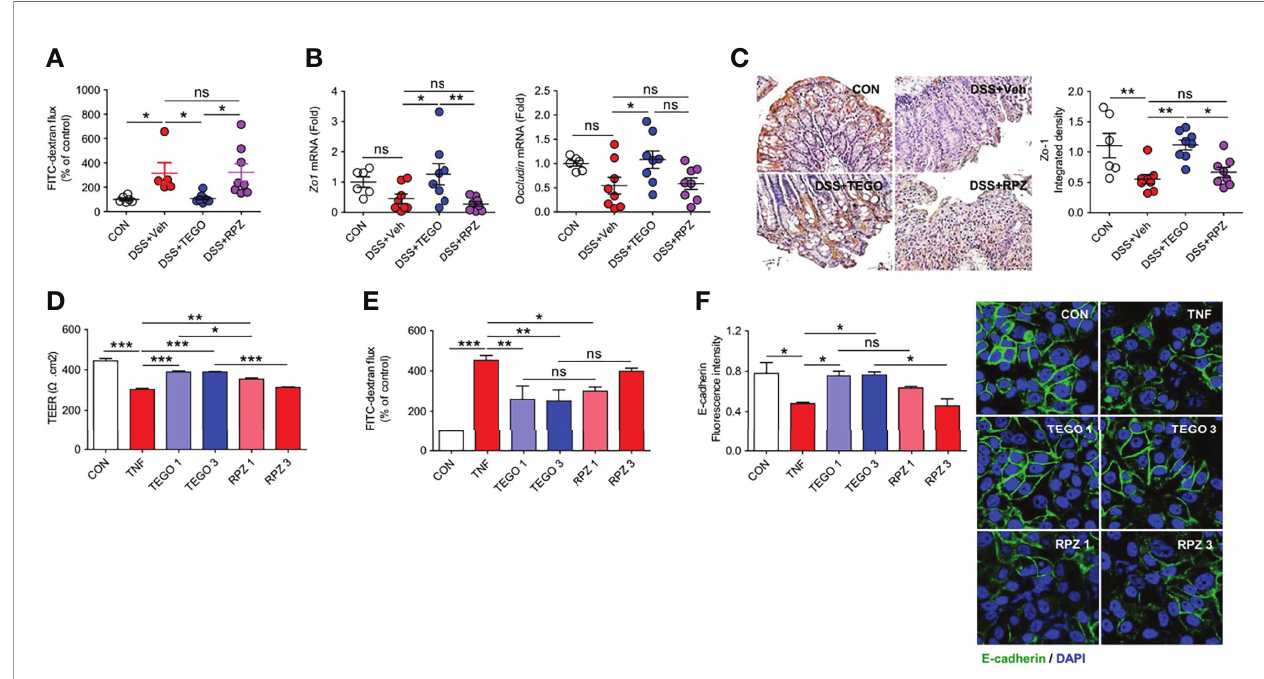
FIGURE 3 | Tegoprazan restores intestinal epithelial barrier function. (A – C) In vivo intestinal permeability assay using the DSS model was described in online methods: CON (n = 6), DSS+Veh, DSS+TEGO, and DSS+RPZ (each n = 8). (A) FITC-dextran fl ux (arbitrary unit), plotted as percentage of control. (B) Gene expression level of Zo1 and Occludin . Data represent the mean of triplicate real-time quantitative RT-PCR. (C) Representative immunohistochemical images and densitometric analysis of Zo-1 protein. (D – F) Caco-2 cell monolayers in a Transwell plate or culture plate were treated with TNF- a (40 ng/mL) for 48 h to disrupt the epithelial barrier. (D) TEER measurement. (E) FITC-dextran fl ux (arbitrary unit), plotted as a percentage of control. (F) Quanti fi cation of the fl uorescence intensity of E- cadherin (arbitrary unit) and representative image of E-cadherin. Data represent the mean ± standard error of the mean (S.E.M) of 3 independent experiments. Signi fi cance is indicated by * p < 0.05, ** p < 0.01, and *** p < 0.001 using one-way ANOVA followed by Dunnett ’ s multiple comparison test (A − D) or two-way ANOVA followed by Bonferroni post hoc test (E) . ns, not signi fi cant; CON, treated with DMSO; TNF- a , tumor necrosis factor- a ; TEGO 1, treated with TNF- a and 1.0 m M tegoprazan; TEGO 3, treated with TNF- a and 3.0 m M tegoprazan; RPZ 1, treated with TNF- a and 1.0 m M rabeprazole; RPZ 3, treated with TNF- a and 3.0 m M rabeprazole; Tregs, regulatory T cells; TEER, transepithelial electrical resistance; FITC, fl uorescein